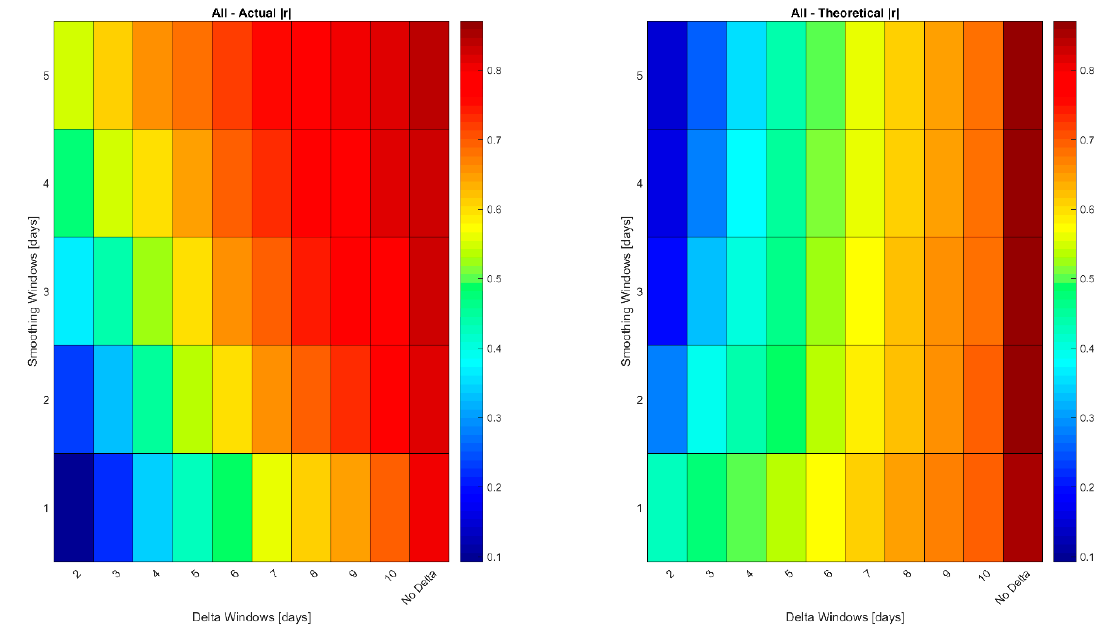
Figure 8. Actual versus theoretical |r| performance of the Δ LUE Canopy retrievals at all sites at different levels of smoothing and values of Δ . N = 5071.